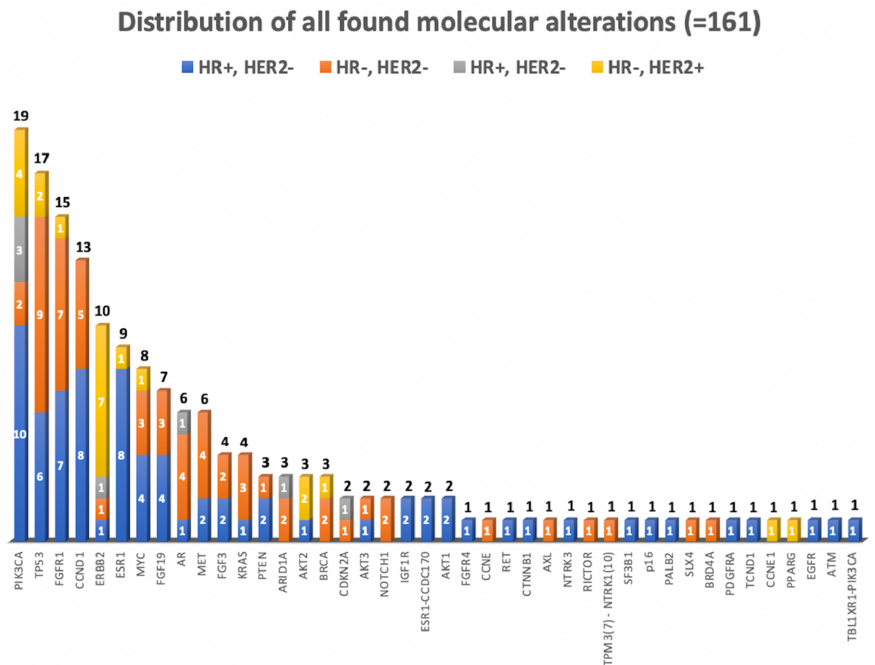
Figure 3. Patient distribution by tumor molecular subtype (by immunohistochemistry (IHC) (n = 100), (HR = hormone receptor, HER2 = human epidermal growth factor) .